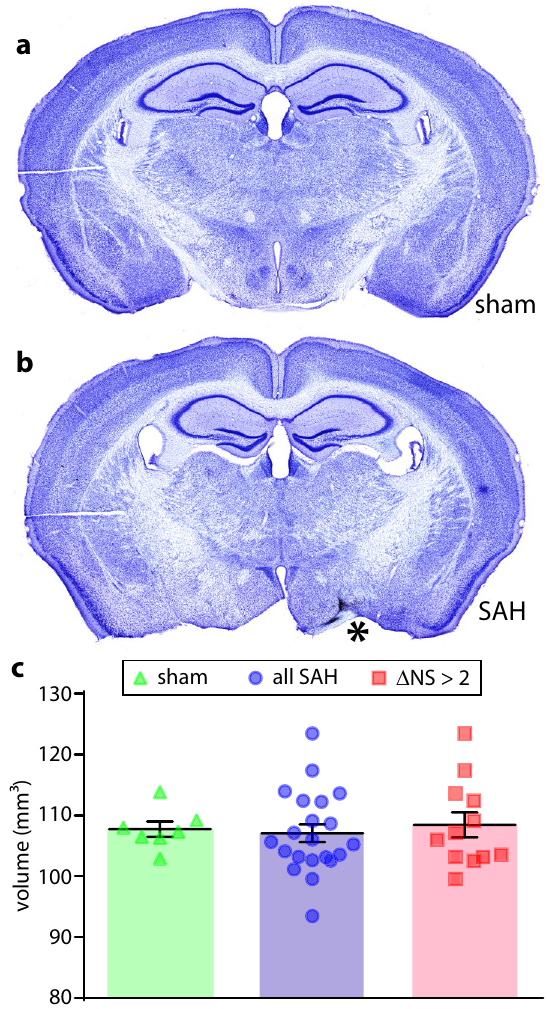
Figure 7. Cerebral volumetrics. Cresyl violet-stained sections from a representative sham-injured animal ( a ) and an animal subjected to endovascular perforation SAH ( b ; * site of arterial rupture). Brain parenchymal volume was quantified over a 2.7 mm antero-posterior portion of the brain centered near the depicted sections for sham-injured animals and both SAH groups ( c ). Mann-Whitney U test with Holm-Bonferroni correction for multiple comparisons ( c